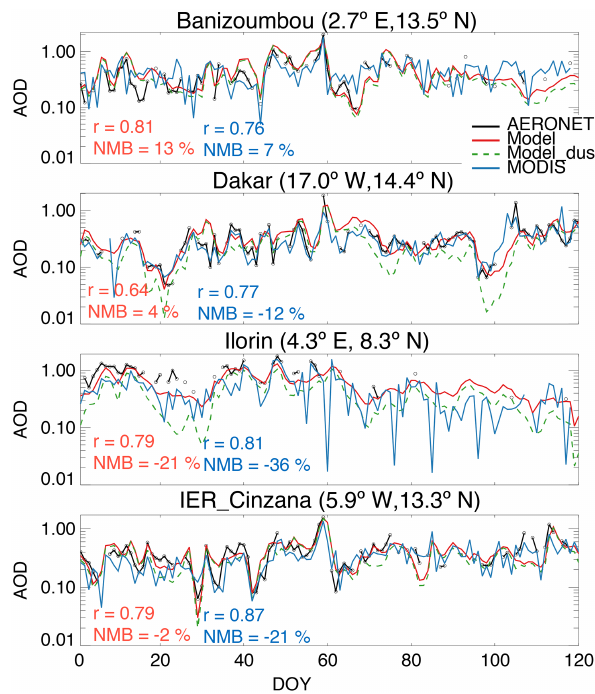
Figure 3. Time series of observed (black lines for AERONET and blue lines for MODIS) and simulated (red lines) AOD at 550nm during January–April 2014. Model results of dust AOD are also shown as green dashed lines. Normalized mean bias (NMB) and correlation (r) statistics between the model and AERONET (red) and between the MODIS and AERONET (blue) are shown as